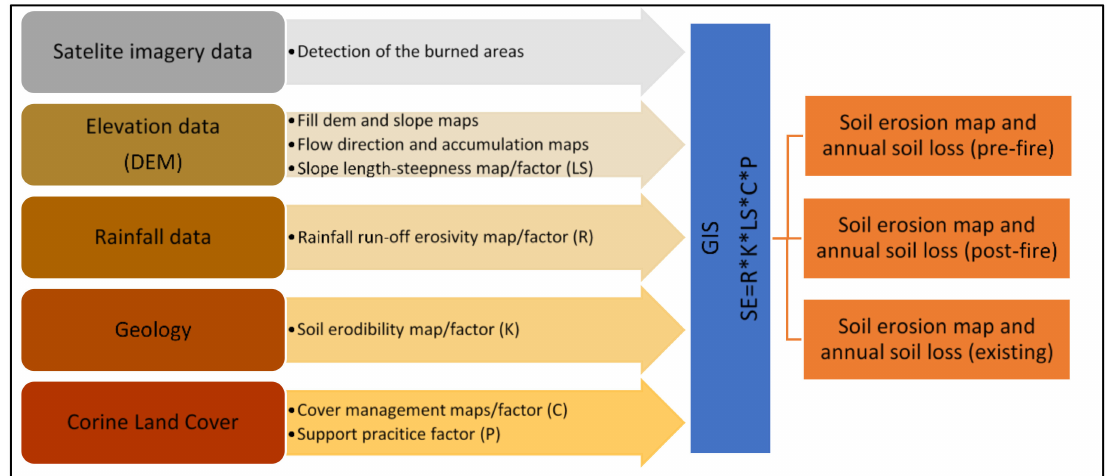
Figure 7. Presentation of the applied